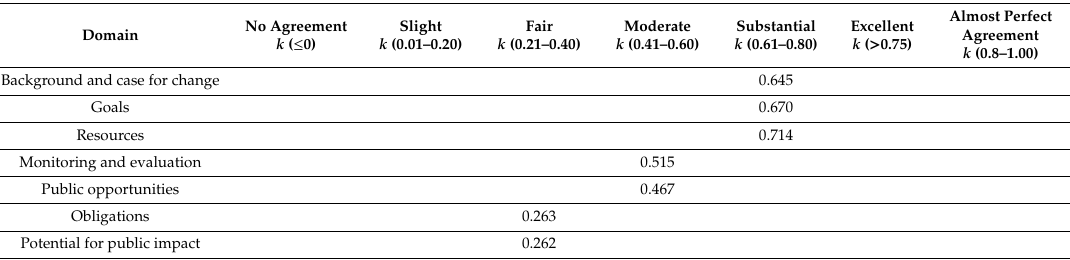
Table 2. Inter-rater reliability for the domains of internal